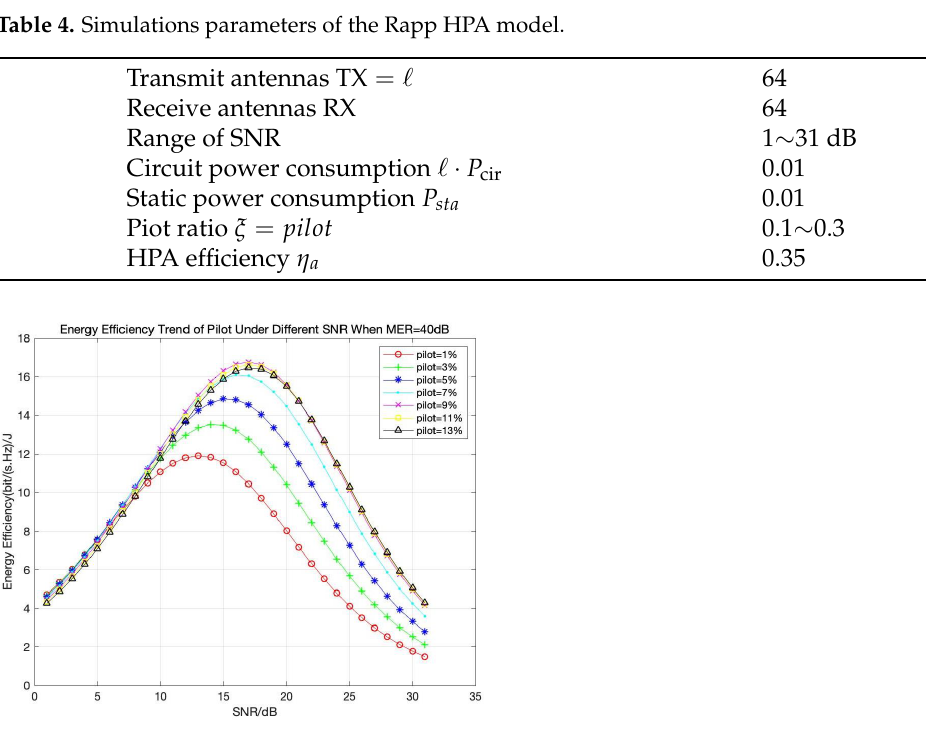
Figure 10. Energy Efficiency Trend of Pilot Under Different SNR When MER = 40 dB.